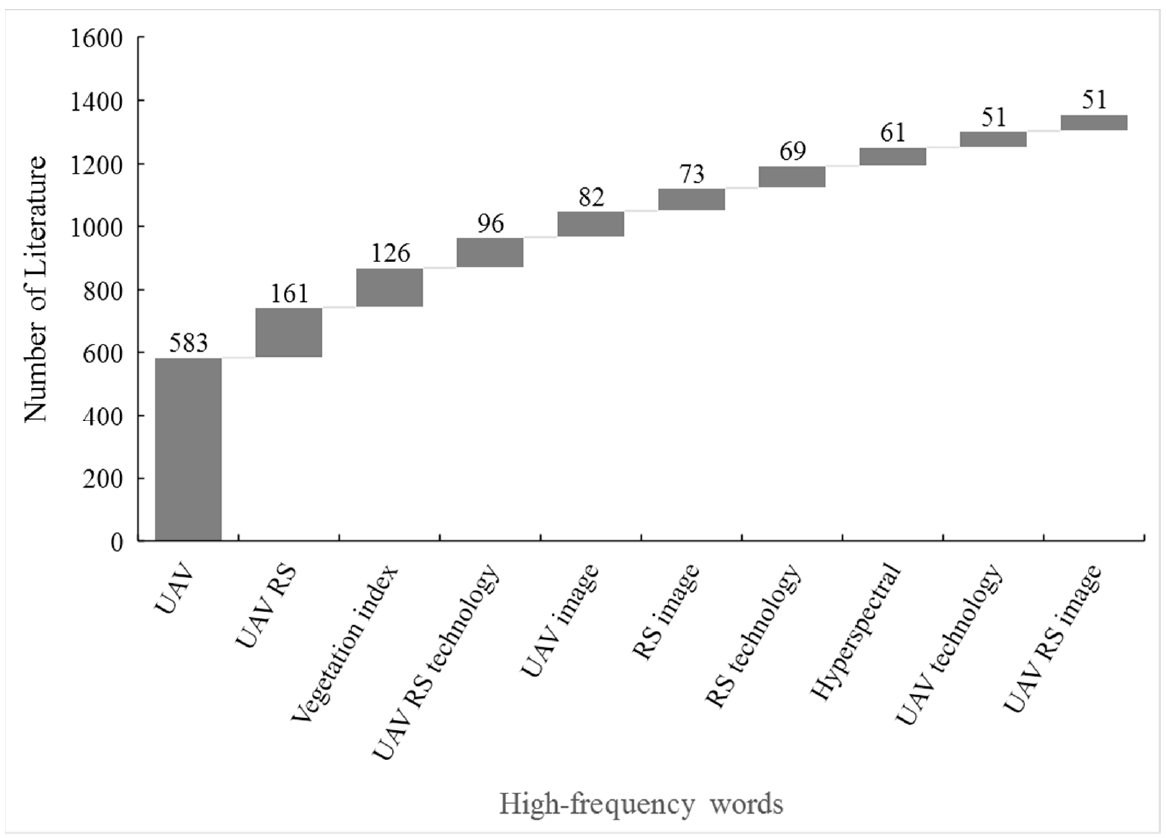
Figure 3. Top ten high-frequency words of UAV-LARS applications in agricultural monitoring of China (1995–2019).